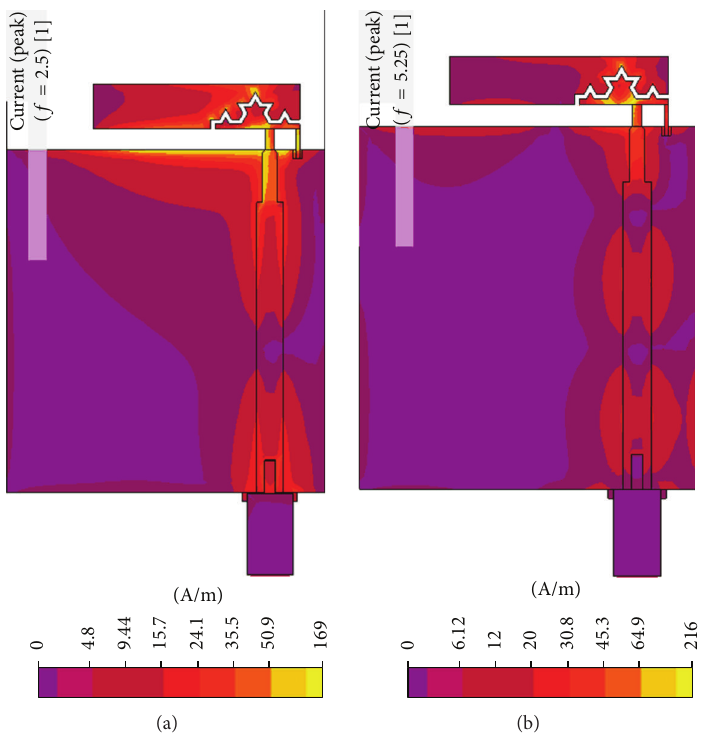
Figure 4: Surface current distributions of the dual-band K2 PIFA at 2.5 GHz and 5.25